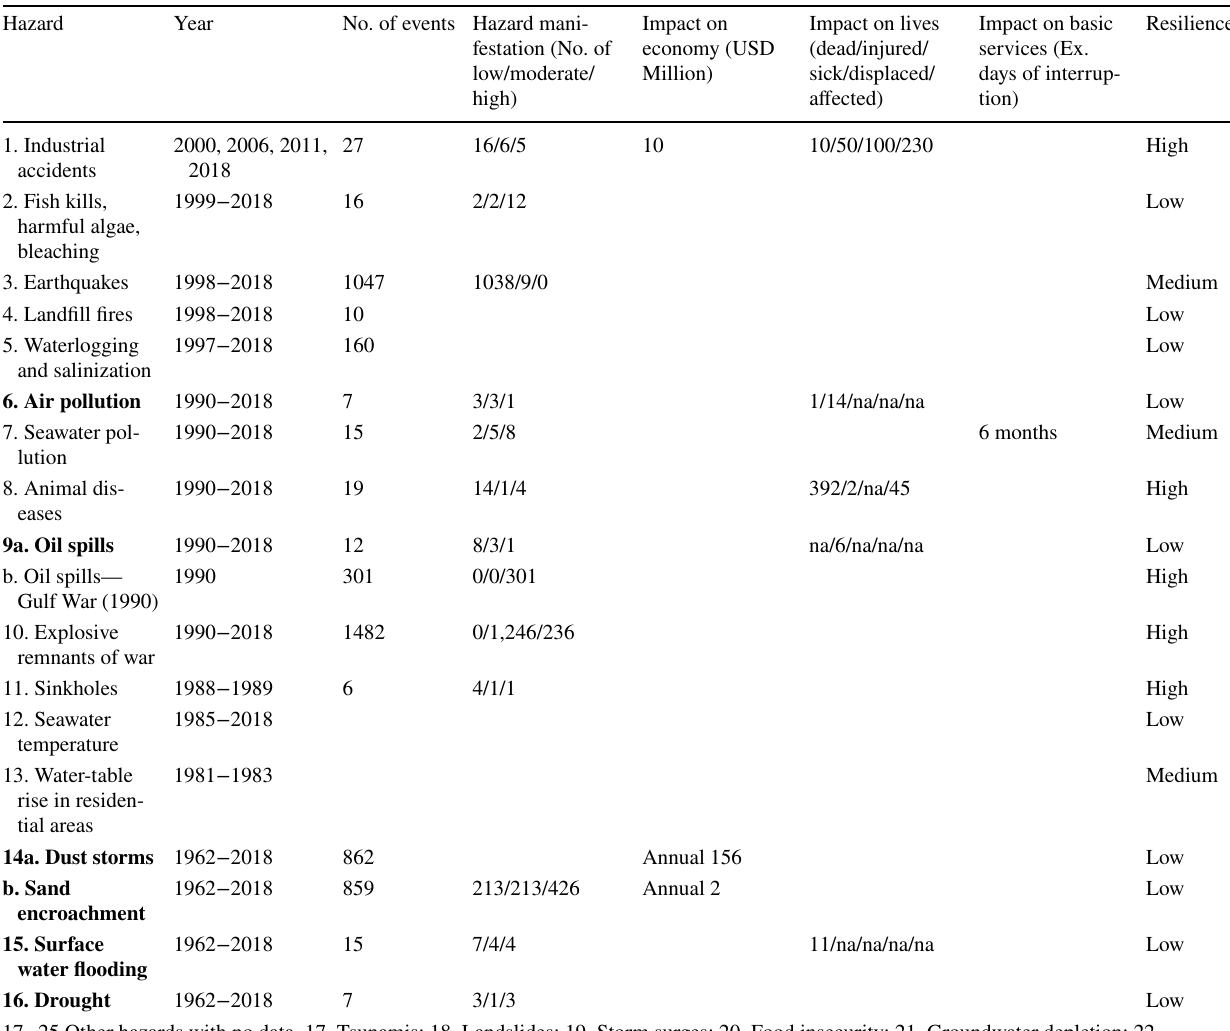
Table 1 Primary data for preliminary hazard assessment and hazard prioritization for Kuwait (arranged by year) (“high priority” hazards are marked in